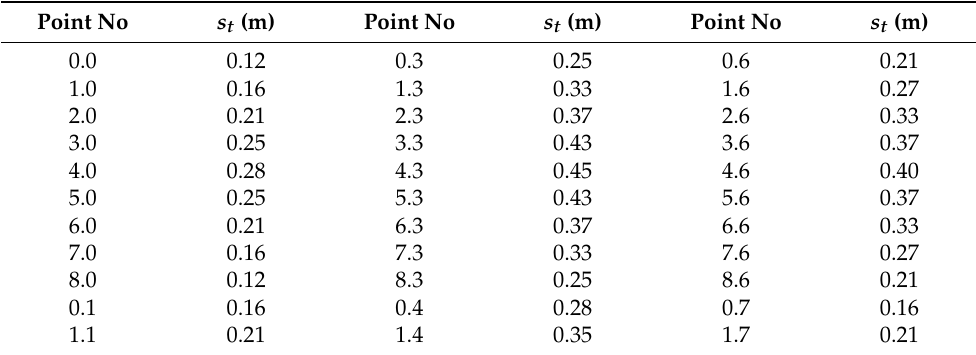
Figure 10. Division of the adopted embankment into calculation areas — numbering of calculation points. It was assumed that the total settlement ( s t ) of the embankment was most significant in the middle and most minor in the corners. Its maximum value is 0.48 m and the minimum at 0.12 m. Final settlement values are shown in Table 1. Table 1. Values of total settlement of the embankment at individual points.